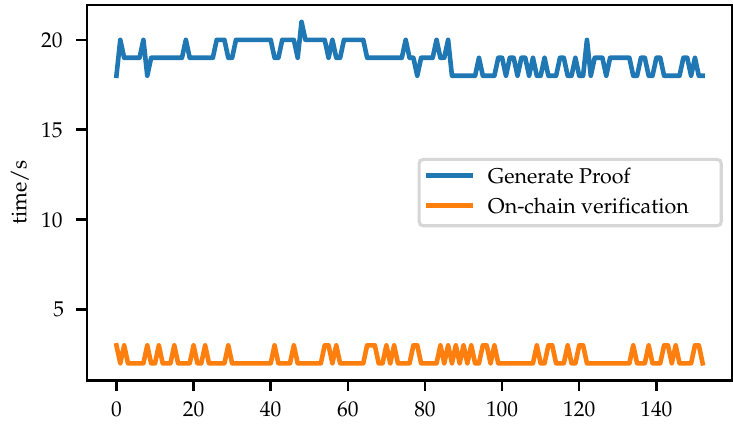
Figure 4. Performance Analysis